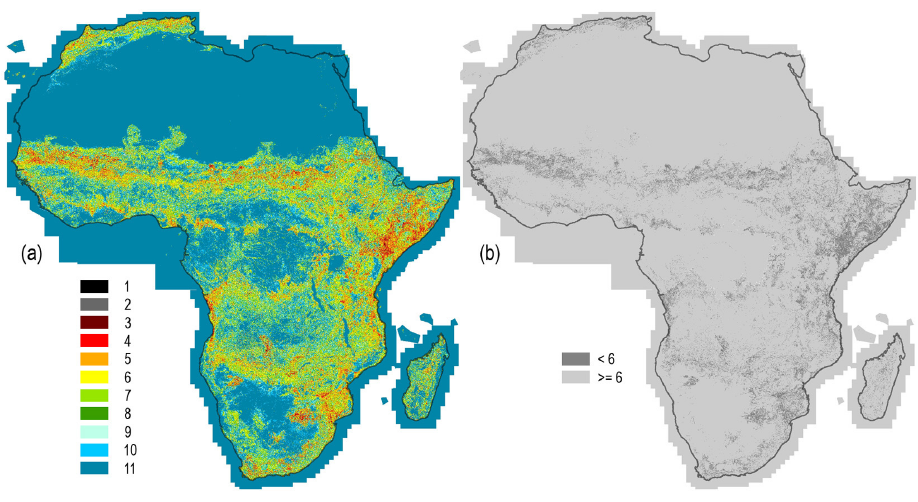
Fig. 7. Spatial representation of the maximum occurrence of a same land cover label over the 11 yr, over Africa. (a) illustrates the exhaustive distribution of maximum occurrence while (b) summarizes this information in a binary stable – unstable